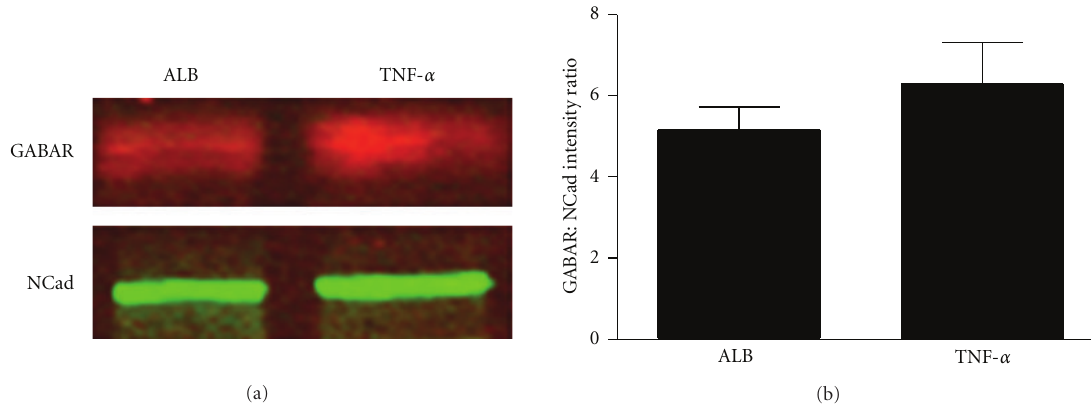
Figure 3: Quantitative western blotting reveals a nonsignificant trend towards an increase in plasma membrane GABA A R. (a) Representative examples of Western Blots of membrane-enriched homogenate fractions from an albumin subject and a TNF α subject that were run on the same gel. GABA A R (red) and plasma membrane protein N-Cadherin (NCad; green) bands were visualized and quantified using the Odyssey IR Imaging System (Li-Cor). (b) Linear intensity quantification of Western Blots of the P2 fraction yields a trend suggesting an increase in GABA A R:NCad ratio following TNF α injection ( P = 0 . 315, n = 10 albumin subjects, n = 8 TNF α subjects). Bars represent group intensity means averaged across 2 Western Blots. Error bars indicate